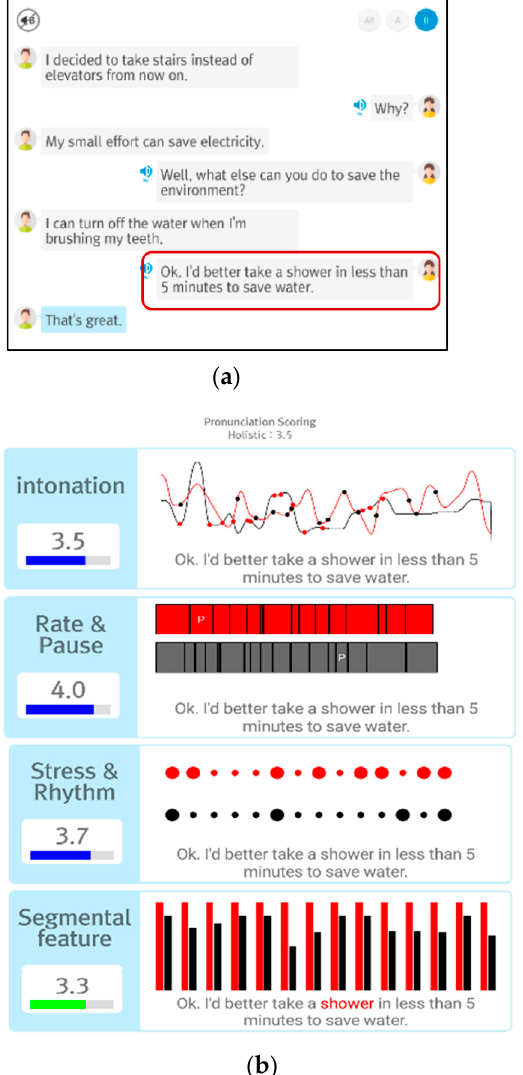
Figure 7. Example of dialogue exercise and fluency scores of the learner and the native speaker with the proposed method: ( a ) example of a role-play dialogue exercise, ( b ) fluency scores feedback.